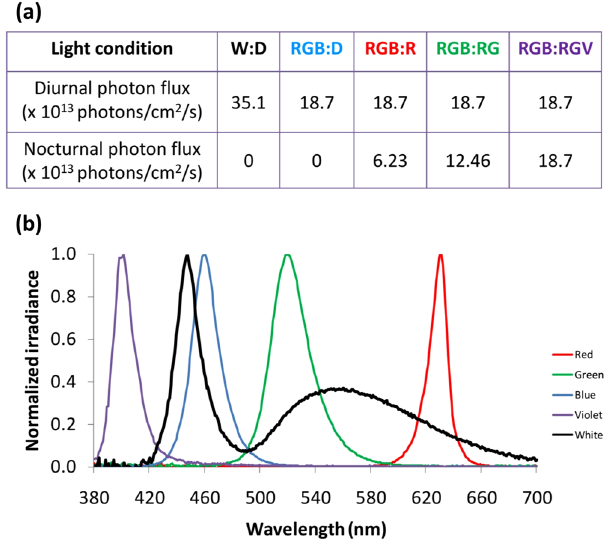
Figure 9. Photon fluxes and spectra for the different light conditions used. ( a ) Photon fluxes used for light at daytime (12 h): night-time (12 h): W:D (white LED:darkness), RGB:D (combined red, green and blue LEDs: darkness), RGB:R (combined RGB LEDs: red LED), RGB:RG (combination of RGB LEDs: red and green LEDs), RGB:RGV (combination of RGB LEDs: combination of red, green and violet LEDs). ( b ) Spectrum for the white LED and the monochromatic components of the different light conditions (red, green, blue and